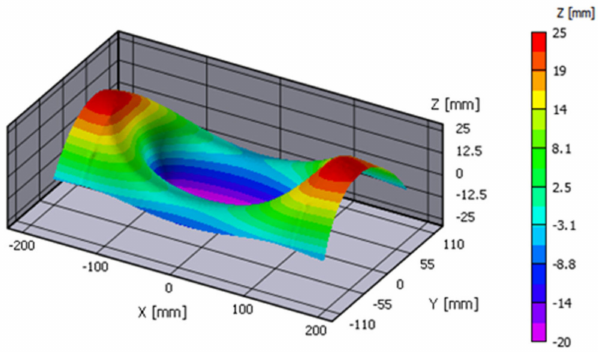
Figure 7. 3D reconstruction using DIC analysis for Specimen #29